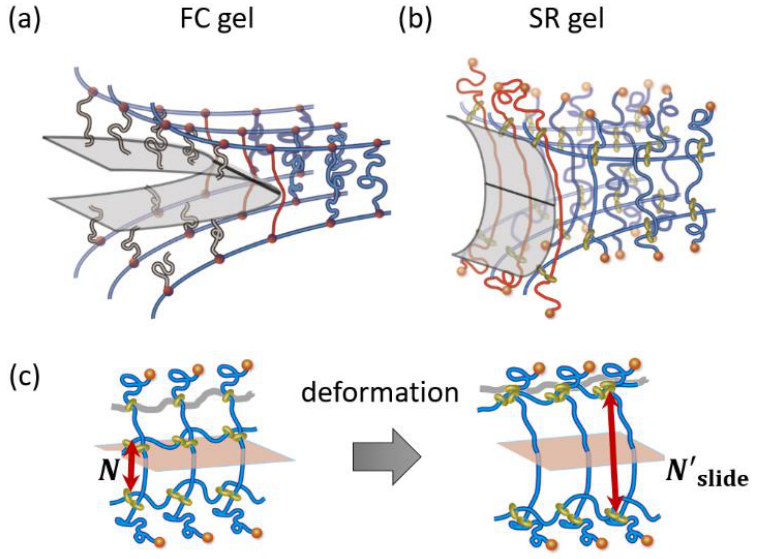
Figure 11. Schematic illustrations of crack propagation in ( a ) FC and ( b ) SR gels, and ( c ) transfor- mation of strand length by sliding of cross-links in SR gels. Reprinted from [23] with permission from American Chemical Society.